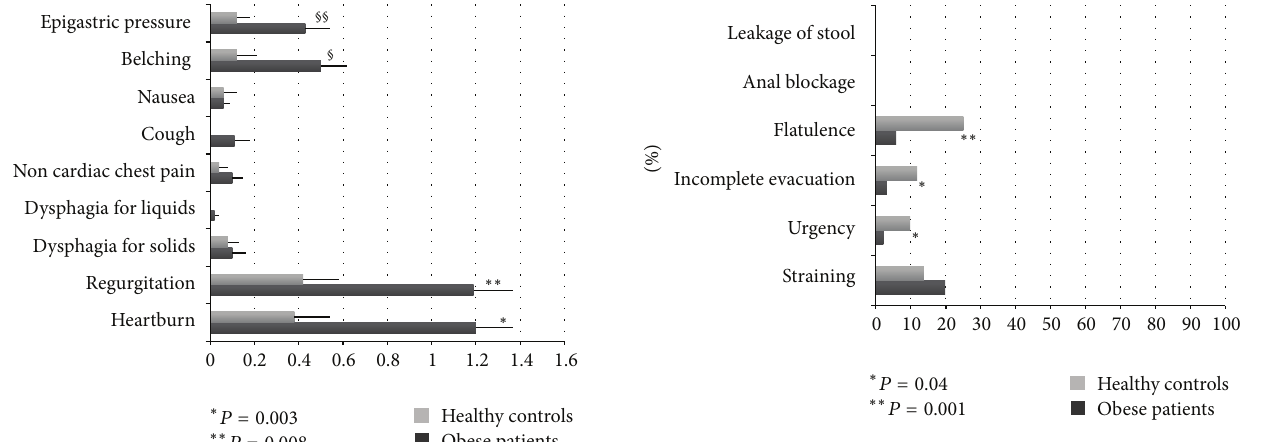
Figure 3: Prevalence of abdomino-pelvic symptoms such as leakage of stool, anal blockage, flatulence, incomplete evacuation, urgency, and straining in obese patients and HC. Data are expressed as percentages